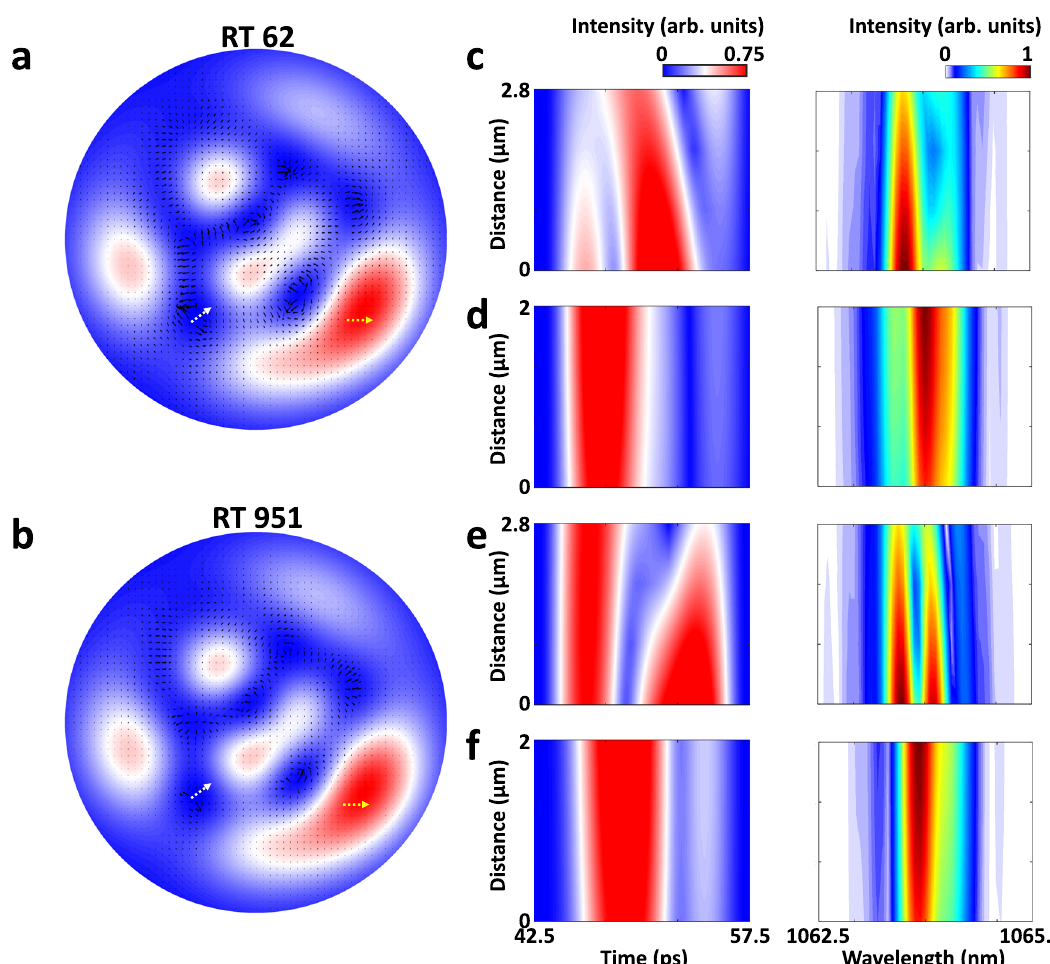
Fig.4|Spatio-spectral-temporalpropertiesof3Ddual-solitonmoleculesinthe simulation. a , b 2D gradient (black arrows) of the average chirp of the 3D soliton molecule across the speckled mode pro fi le, in roundtrips 62 and 951, respectively.